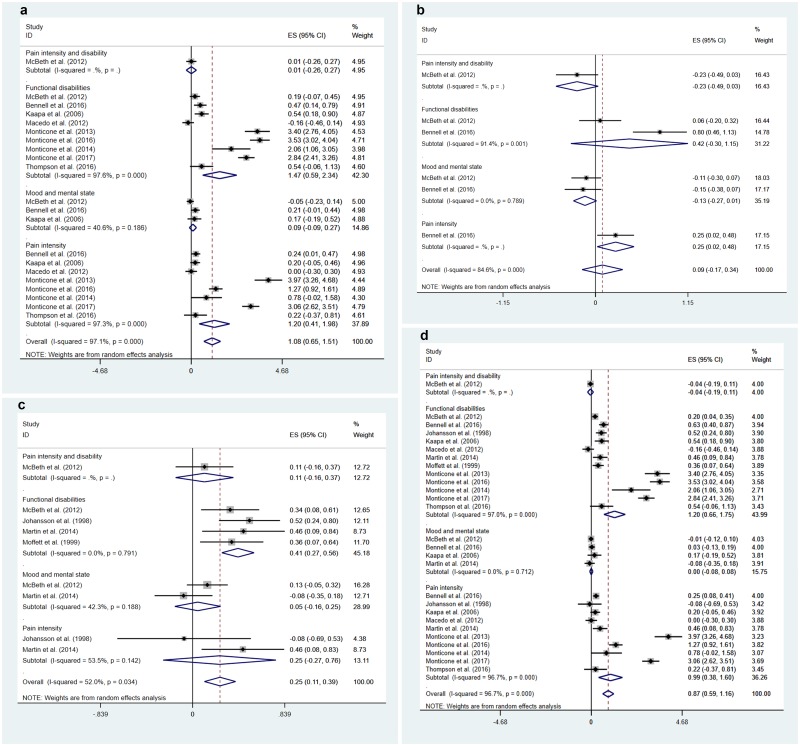
Forest plots for the effects of exercise cum cognitive-behavioural (CBT) intervention at follow-up: (a) exercise alone as control, (b) CBT alone as control, (c) nonspecific control, and (d) all controls.